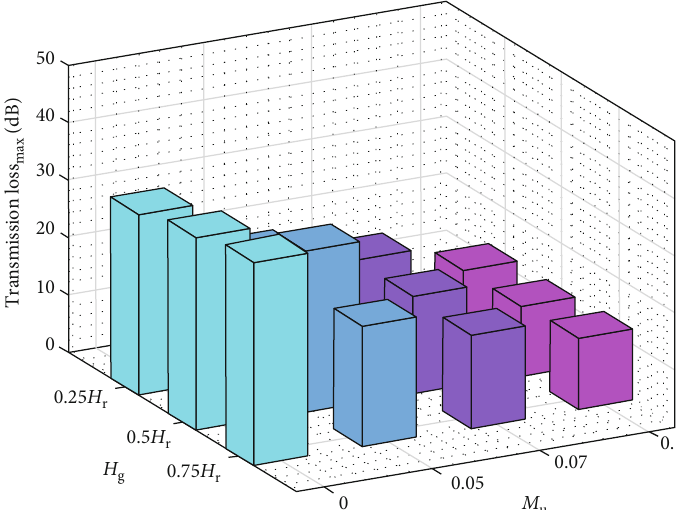
Figure 9: Variation of the global maximum transmission loss with the implementing height H ba ffl e width is set to L